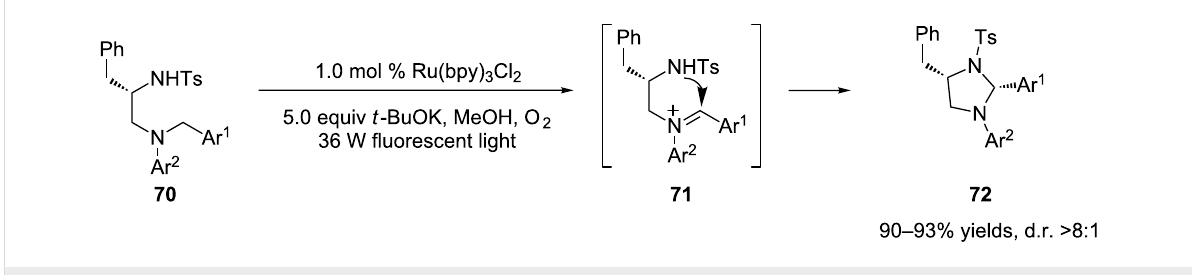
Scheme 18: Intramolecular interception of iminium ions by sulfonamides.